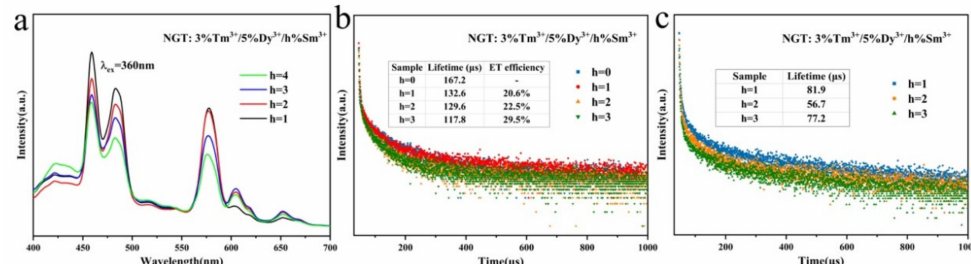
Figure 5. ( a ) PL emission spectra of NGT: 3%Tm 3 + / 5%Dy 3 + / z %Sm 3 + phosphors under the excitation of 360 nm. ( b , c ) The decay curves of NGT: 3%Tm 3 + / 5%Dy 3 + / z %Sm 3 + phosphors monitored at 459 and 487 nm, with excitation at 360 nm. The inset tables show the average lifetimes and energy transfer (ET) e ffi